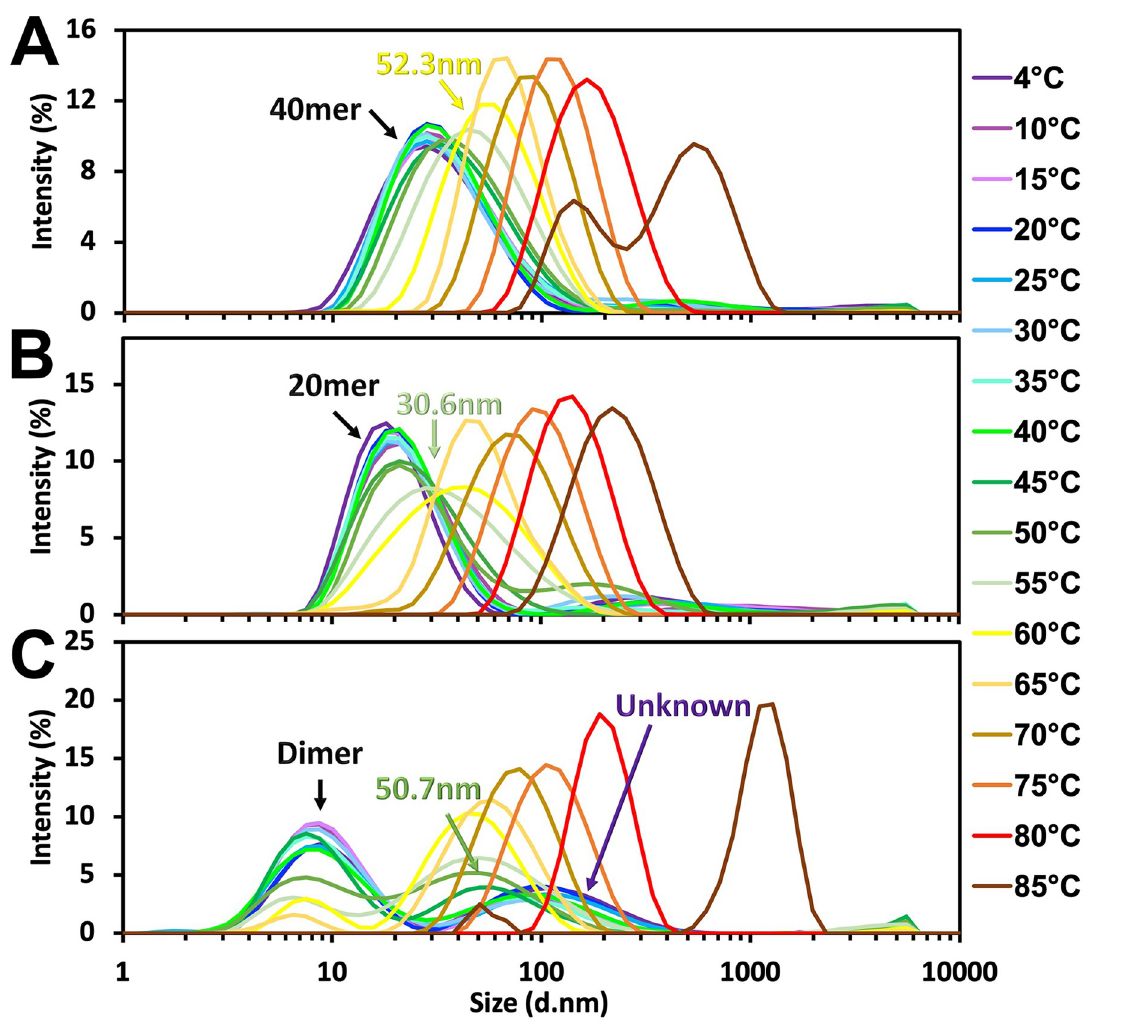
Fig 4. DLS thermal stability profiles of hPER2c 40mer (A) , 20mer (B) , and dimer (C) at gradually increased temperature in 5˚C intervals. The DLS spectra were colored from purple to brown with increasing temperatures as indicated by the legend on the right. The peaks corresponding to the hPER2c 40mer, 20mer, dimer and the unknown complex at low temperatures are indicated with black arrows. The signal of significant size changes in all three samples were also indicated with their correspongding